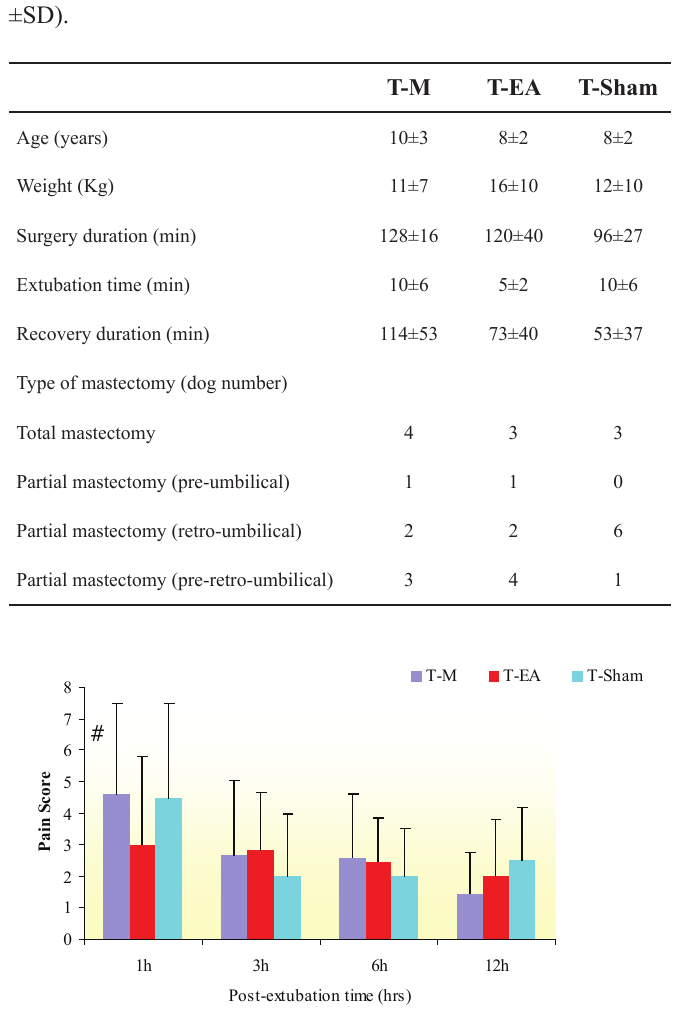
FIGuRE 1 - Mean±SD pain scores in dogs treated with morphine (T-M), electroacupuncture (T-EA) or sham acupuncture (T-Sham) at each time period after tracheal extubation. * Significant increase (P<0.05) when compared with 12 hours post- extubation. # Significant increase (P<0.05) when compared with 3 and 6 hours after tracheal extubation.